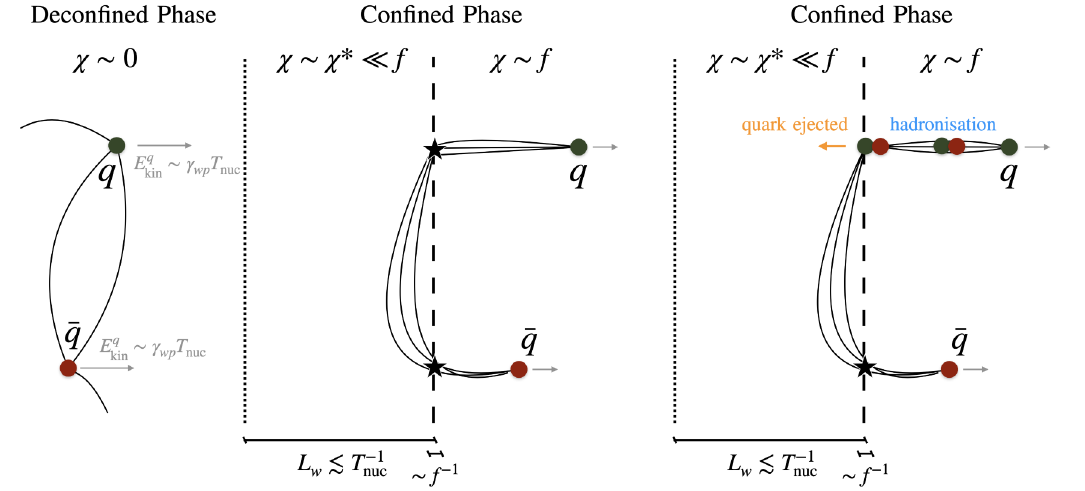
Figure 2 . Quarks entering the bubble as seen in the frame of the bubble wall, together with the associated field lines and quantities defined in the text. The rest energy of the string is minimized if the fluxtubes in the region χ = f point to the bubble wall, rather than if they point to the closest color charge.